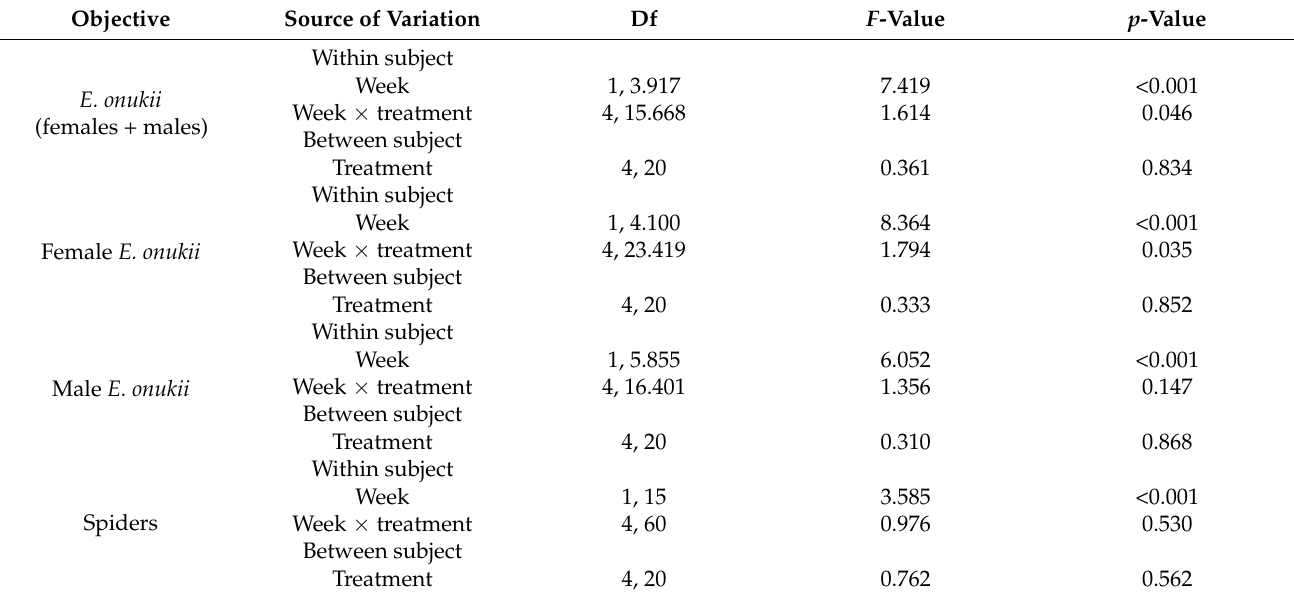
Table 4. Results of repeated-measures ANOVAs comparing the weekly number of E. onukii and spiders collected during the course of the exclosure